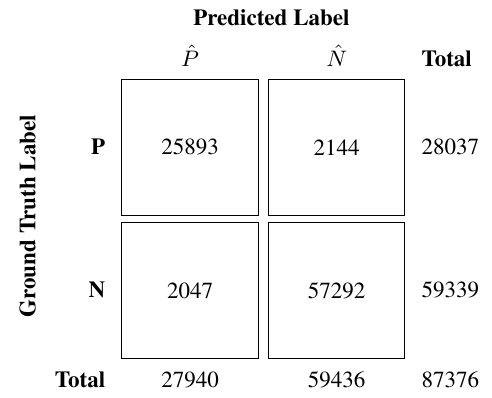
Table 1. The confusion matrix for building construction profiles. P ˆ and N ˆ are the ground truth labels for built-up and un-built, respectively. P and N are the predicted la-bels for built-up and un- built, respectively.